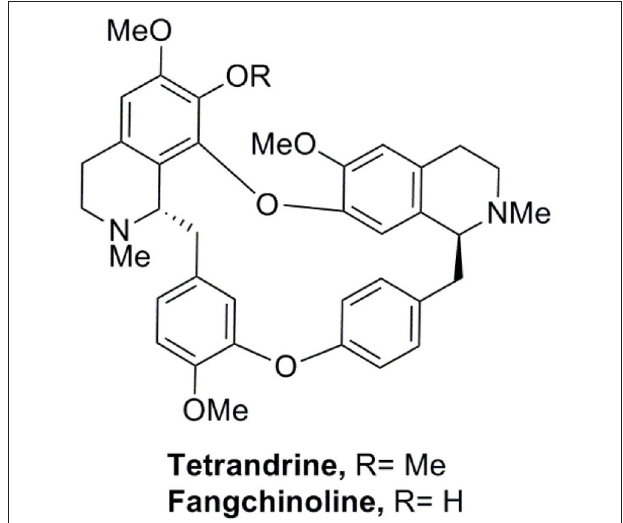
FIGURE 1 | Structure of tetrandine and